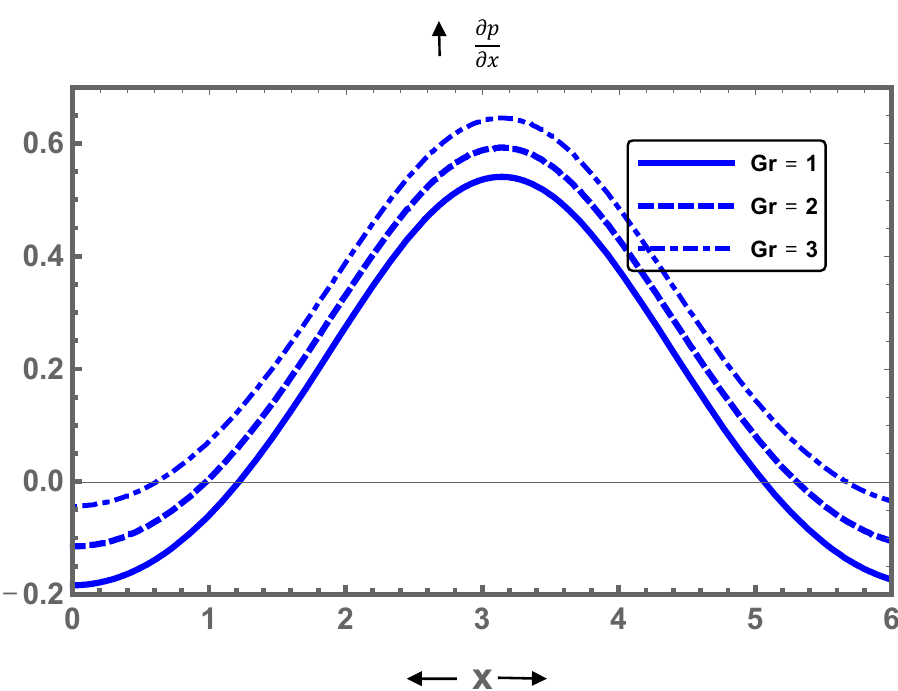
Figure 19. Display of pressure gradient for different values of U HS .